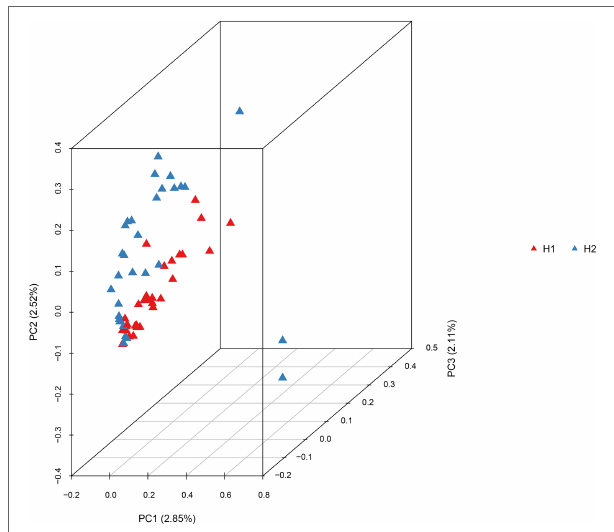
FIGURE 6 | Principal component analysis (PCA) plot of G. haimaensis at two sites based on the 294,734